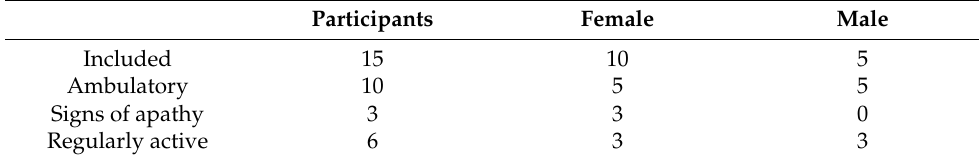
Table 2. Baseline characteristics of participants.